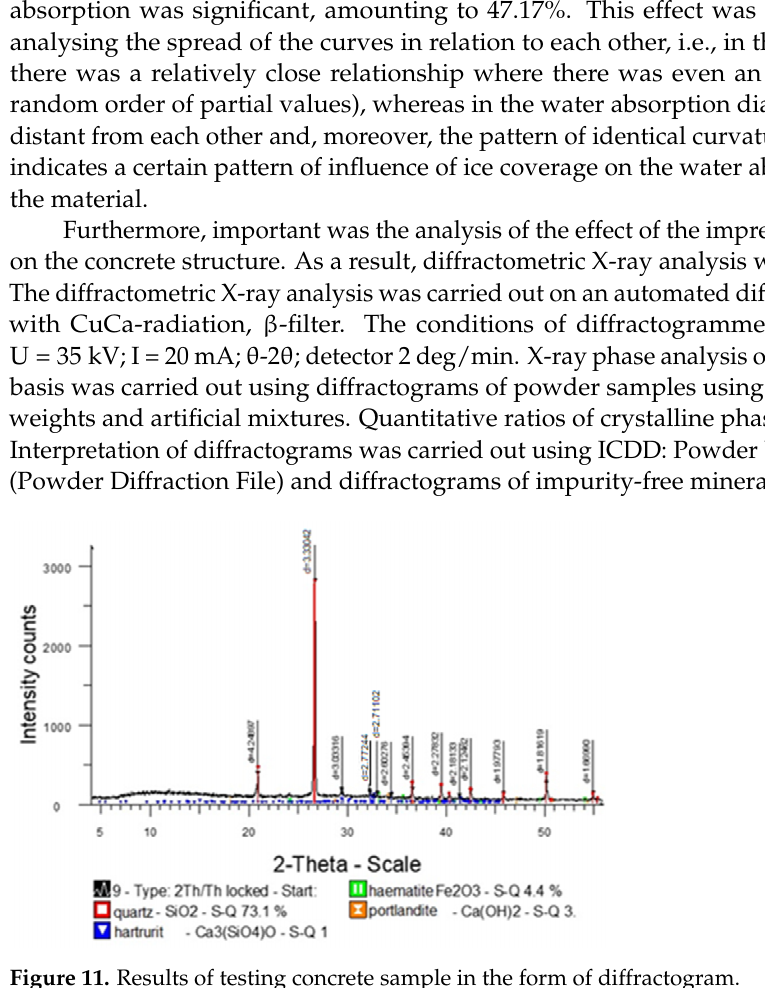
Figure 11. Results of testing concrete sample in the form of diffractogram